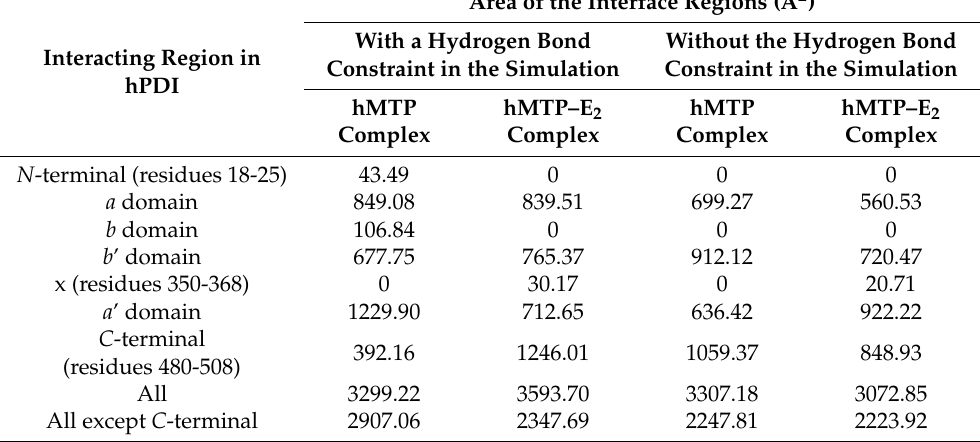
Table 2. Area of the interface regions in the four conformations of hMTP and hMTP–E 2 complexes after MD